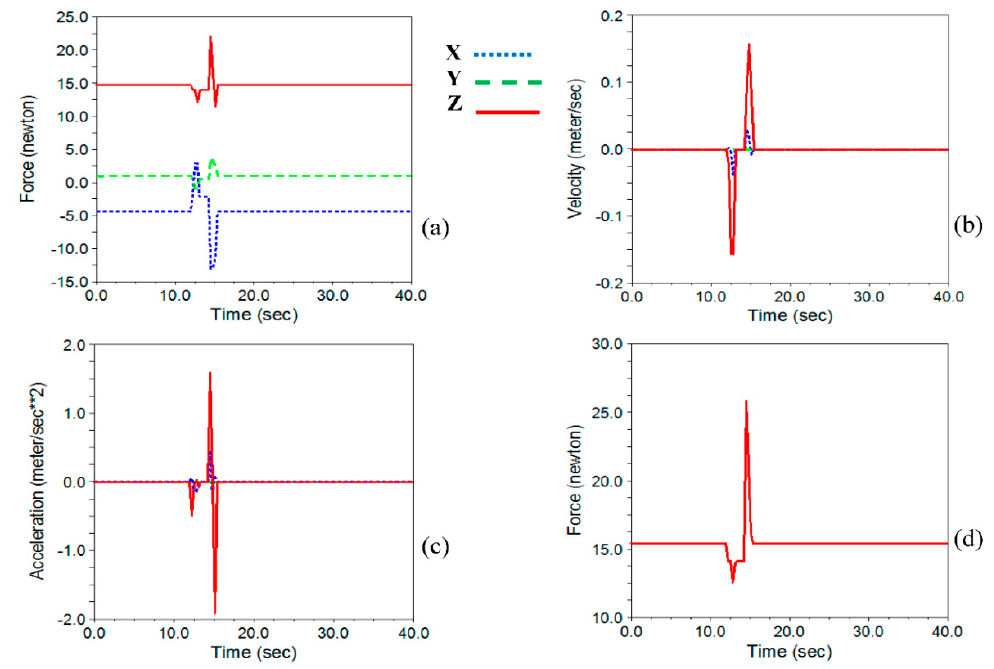
Figure 28. Results of ADAMS software simulation to determine the characteristics of the pneumatic jack of the cleaning subsystem (10 fish per minute). In this figure, ( a – d ) are force, velocity, acceleration, and resultant of the force in three direction respectively.